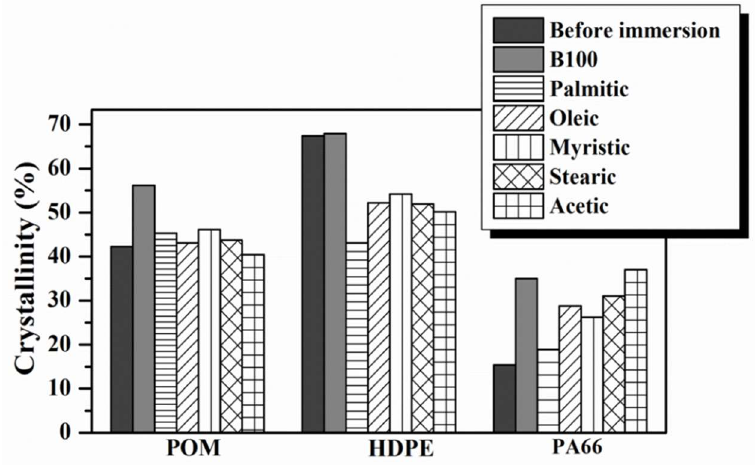
Figure 5. Variation in the crystallinity of the polymer materials after immersion in B100 and B100–acids blends.